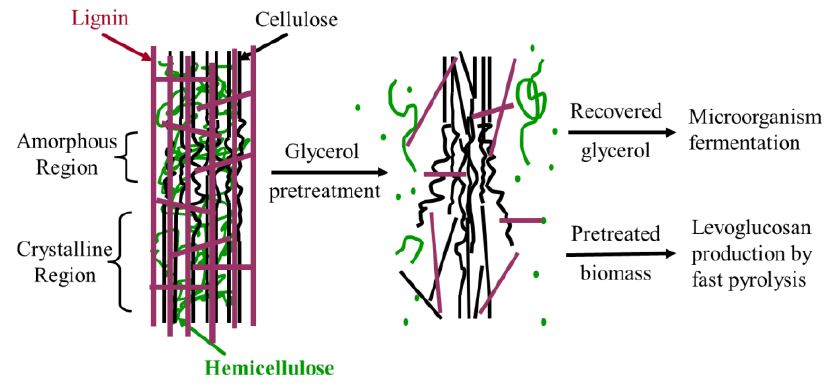
Figure 1. The scheme of this study.